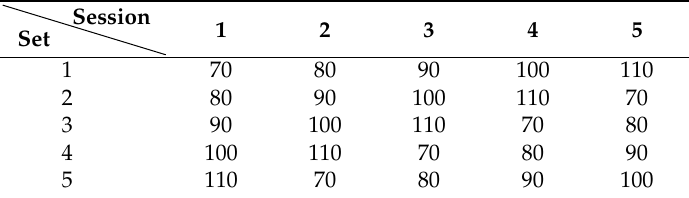
Table 2. Schema illustrating the muscle stimulation current protocol